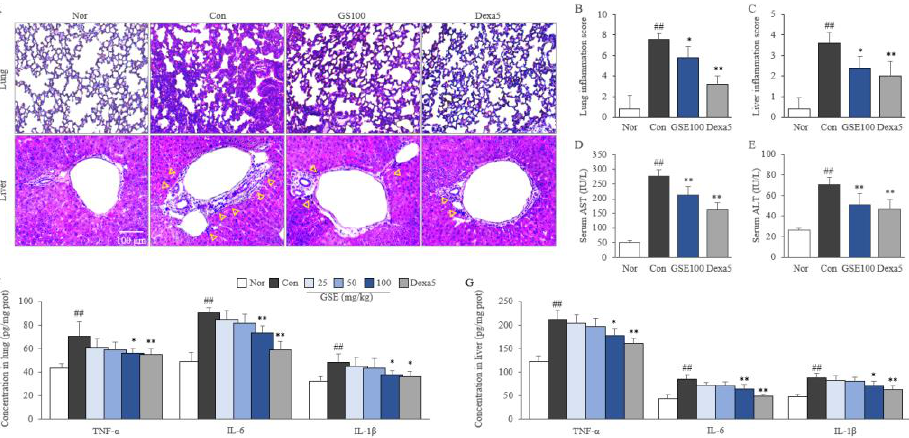
Figure 3. Effects of GSE on pulmonary and hepatic injury. H&E staining ( A ) of lung and liver tissues was performed, and representative photographs (200 × magnification) were evaluated for the inflammation scores ( B , C ). The yellow triangles indicate the infiltration of immune cells. Serum aspartate aminotransferase (AST) and alanine aminotransferase (ALT) were measured ( D , E ). The levels of proinflammatory cytokine in the lung ( F ) and liver ( G ) tissues were analyzed using ELISA. Samples were grouped according to treatment: normal (Nor), control (Con), ginseng sprout extract (GSE), and dexamethasone (Dexa5). The data are presented as the mean ± SD. ## p < 0.01 compared with the normal group; * p < 0.05, ** p < 0.01 compared with the control group. 2.5. GSE Suppressed Oxidative-Stress-Related Molecules in Lung and Liver Tissues LPS (30 mg/kg) injection substantially upregulated the expression of iNOS and COX2, as well as the production of NO in both the lung and liver. GSE treatments sig- nificantly reduced the oxidative molecules iNOS ( p < 0.01) and COX2 ( p < 0.05 for GSE50 and p < 0.01 for GSE100) and the production of NO ( p < 0.01) in the lung (Figure 4A,B,E). Furthermore, GSE (especially, 50 and 100 mg/kg) downregulated the protein expression of iNOS ( p < 0.01) and COX2 ( p < 0.05) and the production of NO ( p < 0.05 for GSE25, p < 0.01 for GSE 50 and 100) in the liver (Figure 4C,D,F). Figure 4. Effects of GSE on inflammatory mediators in pulmonary and hepatic tissues. The protein levels of iNOS and COX2 in the lung ( A , B ) and liver (C, D ) tissues were assessed by Western blot,